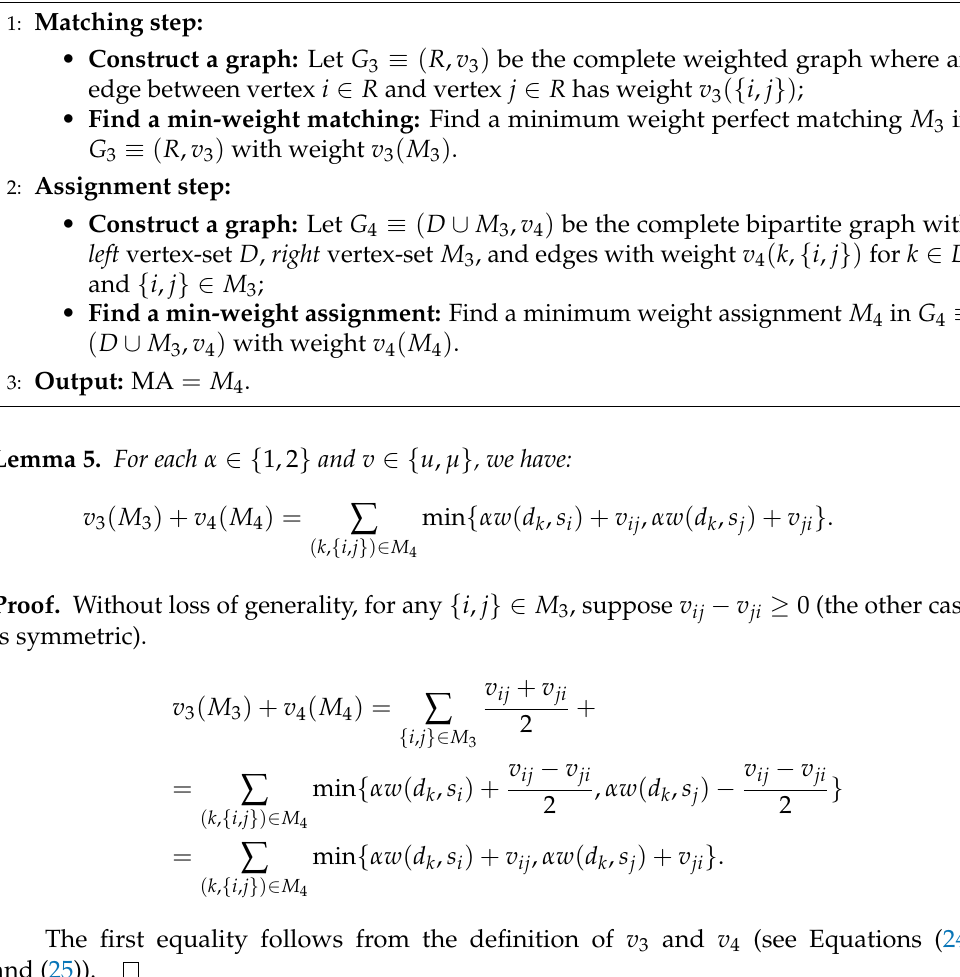
Algorithm 2 Match-and-assign algorithm (MA ( α , v )